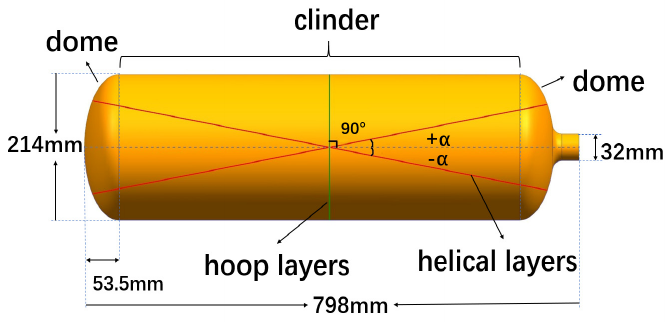
Figure 1. Size of liner and fi lament winding direction.